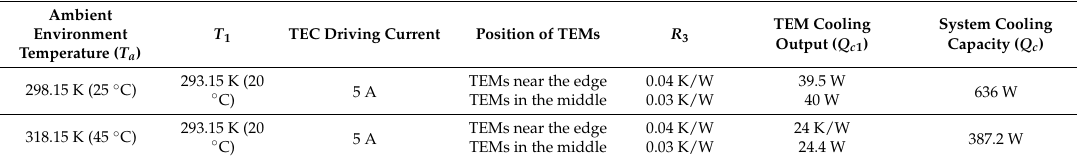
Table 3. The estimated cooling capacity of the system in different ambient environments.